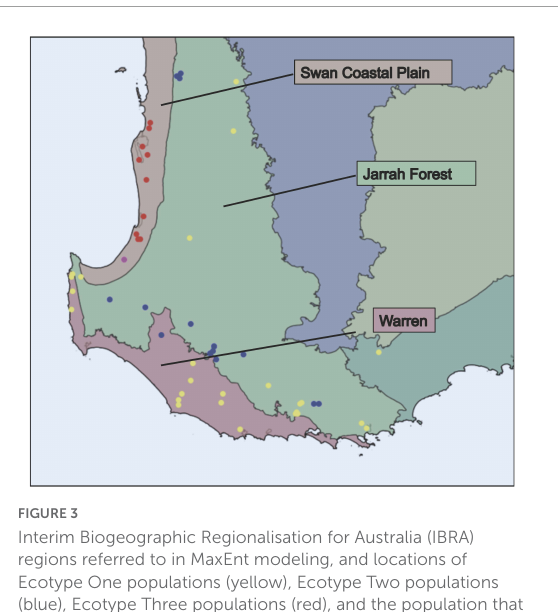
FIGURE3 Interim Biogeographic Regionalisation for Australia (IBRA) regions referred to in MaxEnt modeling, and locations of Ecotype One populations (yellow), Ecotype Two populations (blue), Ecotype Three populations (red), and the population that contained flowers with compounds indicative of more than one ecotype